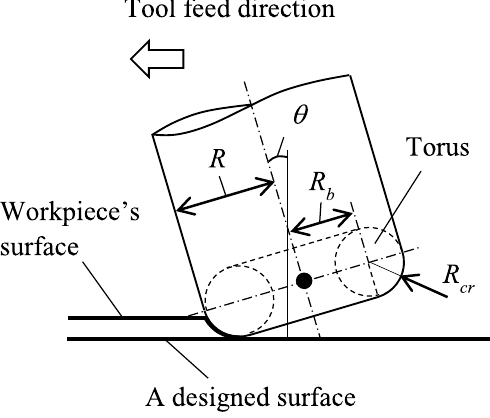
Fig. 5. An assigned torus and several